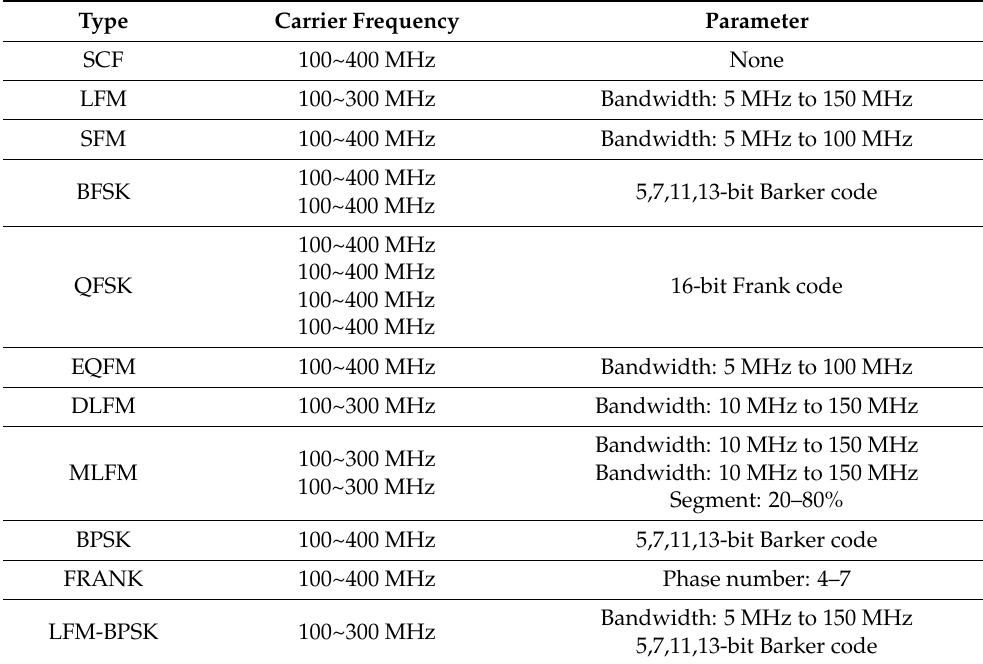
Table 1. Parameters of radar emitter signals with eleven different intra-pulse